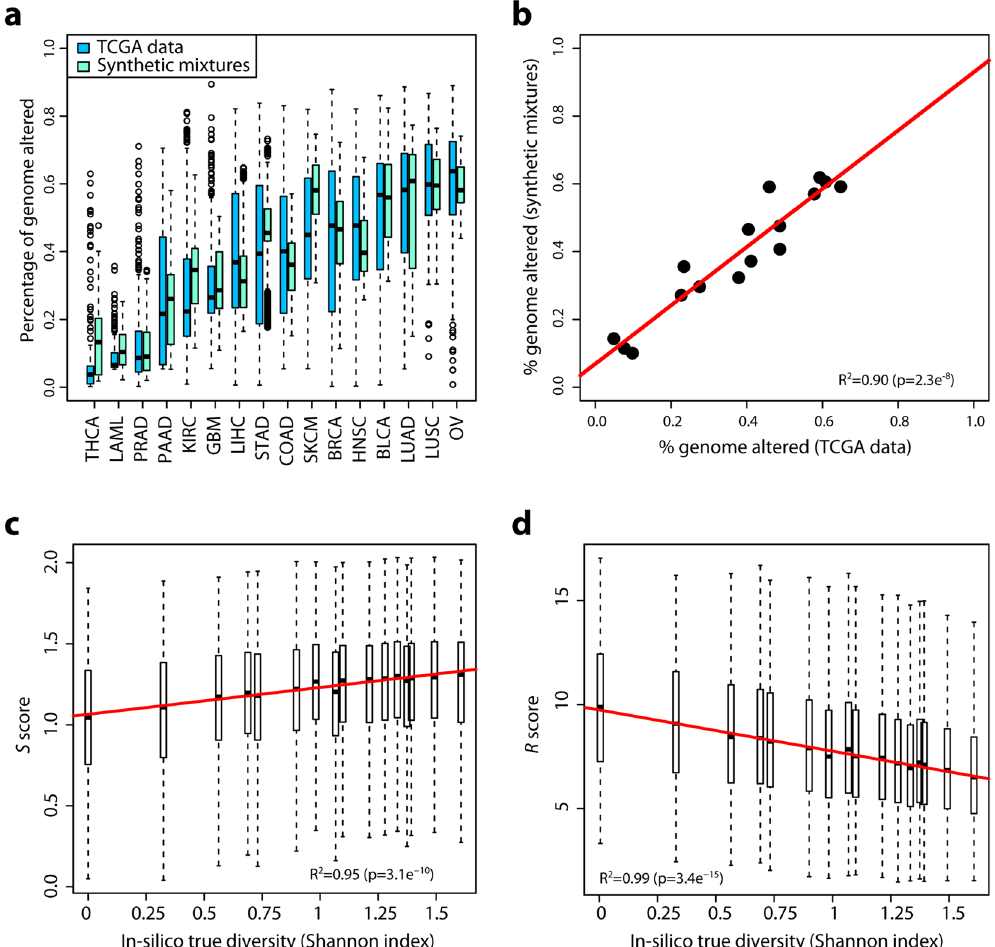
Figure 2. In-silico clonal mixtures. ( a ) Distributions of the percentage of altered genome in samples from the TCGA cohorts (blue) and the computationally simulated copy number profiles (cyan). ( b ) Median percentage of genome altered in TCGA and simulated data across cancer types. Each point is a different cancer type and the red line indicates the linear fit between the two datasets. ( c , d ) Correlation of the S score ( c ) and R score ( d ) with the true diversity in in-silico mixtures. the red line indicates the linear fit of the median scores at each possible diversity measure. Boxplots: boxes represent the middle quartiles, whiskers indicate the 95% confidence intervals, horizontal bars show the median and outliers are highlighted by